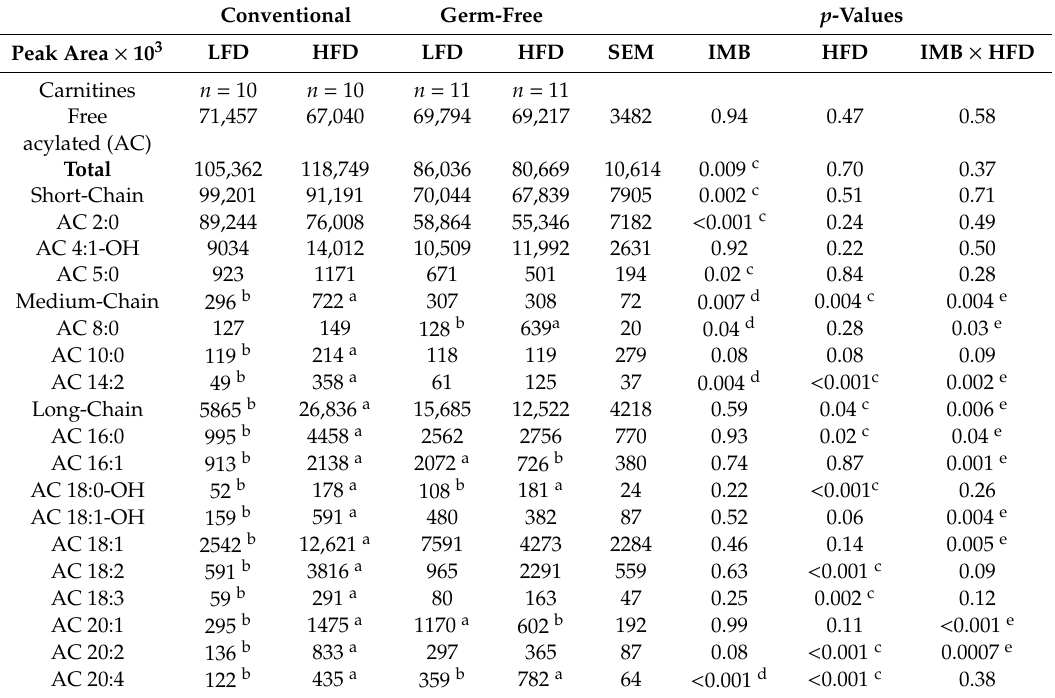
Table 6. E ff ect of the low- and high-fat diets on hepatic carnitine levels in conventional and germ-free male Tac:SW mice.